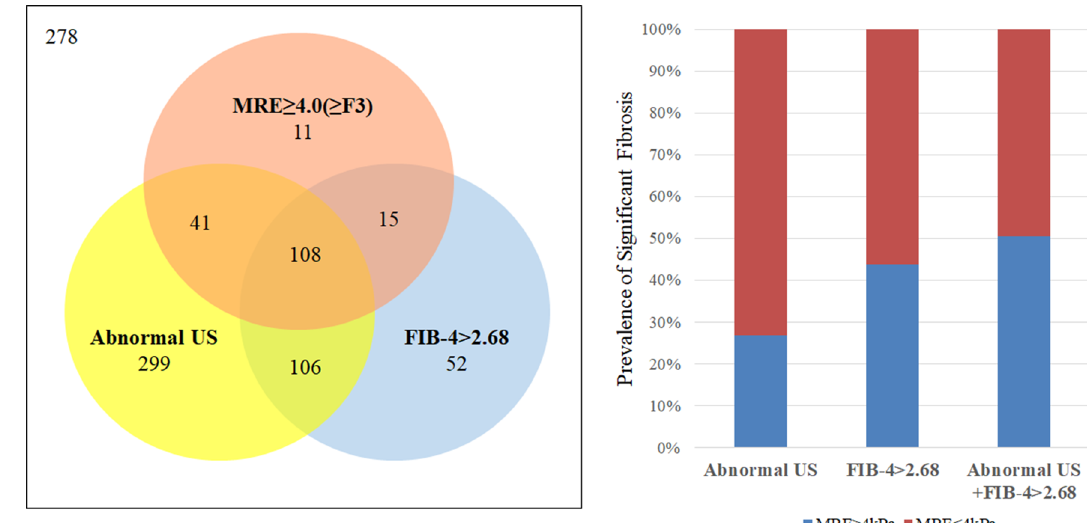
Figure 3. Diagram showing the association of US findings, MRE, and FIB-4. Numbers in circles indicate patient numbers. Abnormal US refers to patients with the sonographic result of chronic liver disease or liver